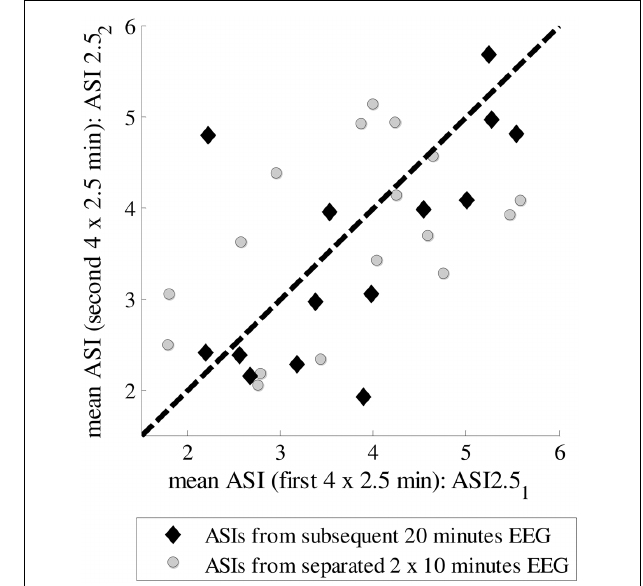
FIGURE 3 | ASIs for subsequent 10-min epochs from the same quiet sleep period or for separate 10-min epochs from two different quiet sleep periods.